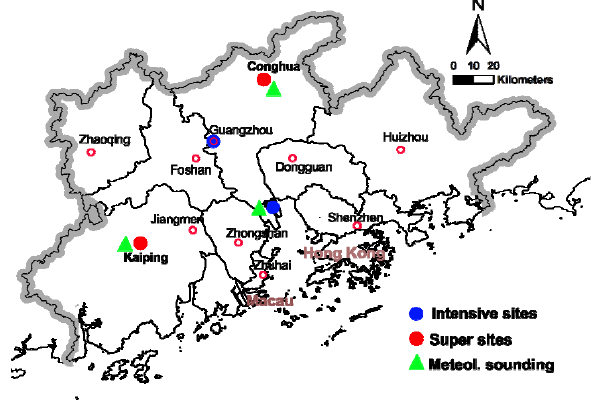
Fig. 1. The location of the Kaiping monitoring site in the PRD region.